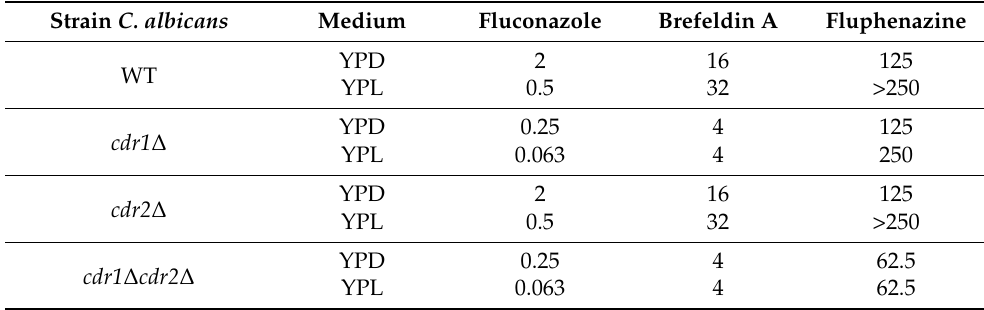
Table 1. MIC 50 ( µ g/mL) of FLC, brefeldin A, and fluphenazine against C. albicans cultured on YPD (glucose) or YPL (lactate)